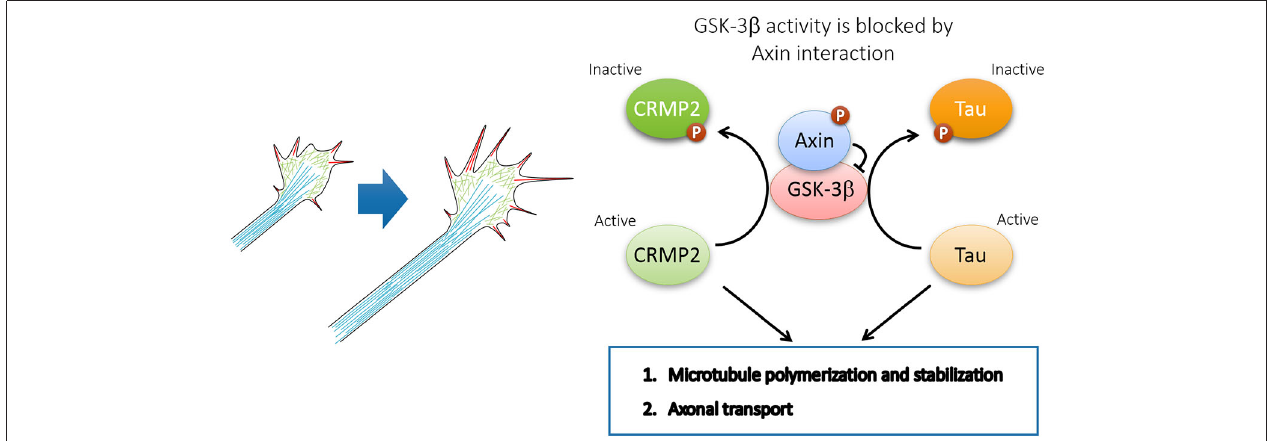
FIGURE 5 | Axin-GSK3 β signaling promotes axon growth through microtubule assembly and axonal transport . GSK3 β inactivation by Axin interaction maintains CRMP2 and Tau in active form and coordinates the local axon assembly at the growth cone and efficient axon